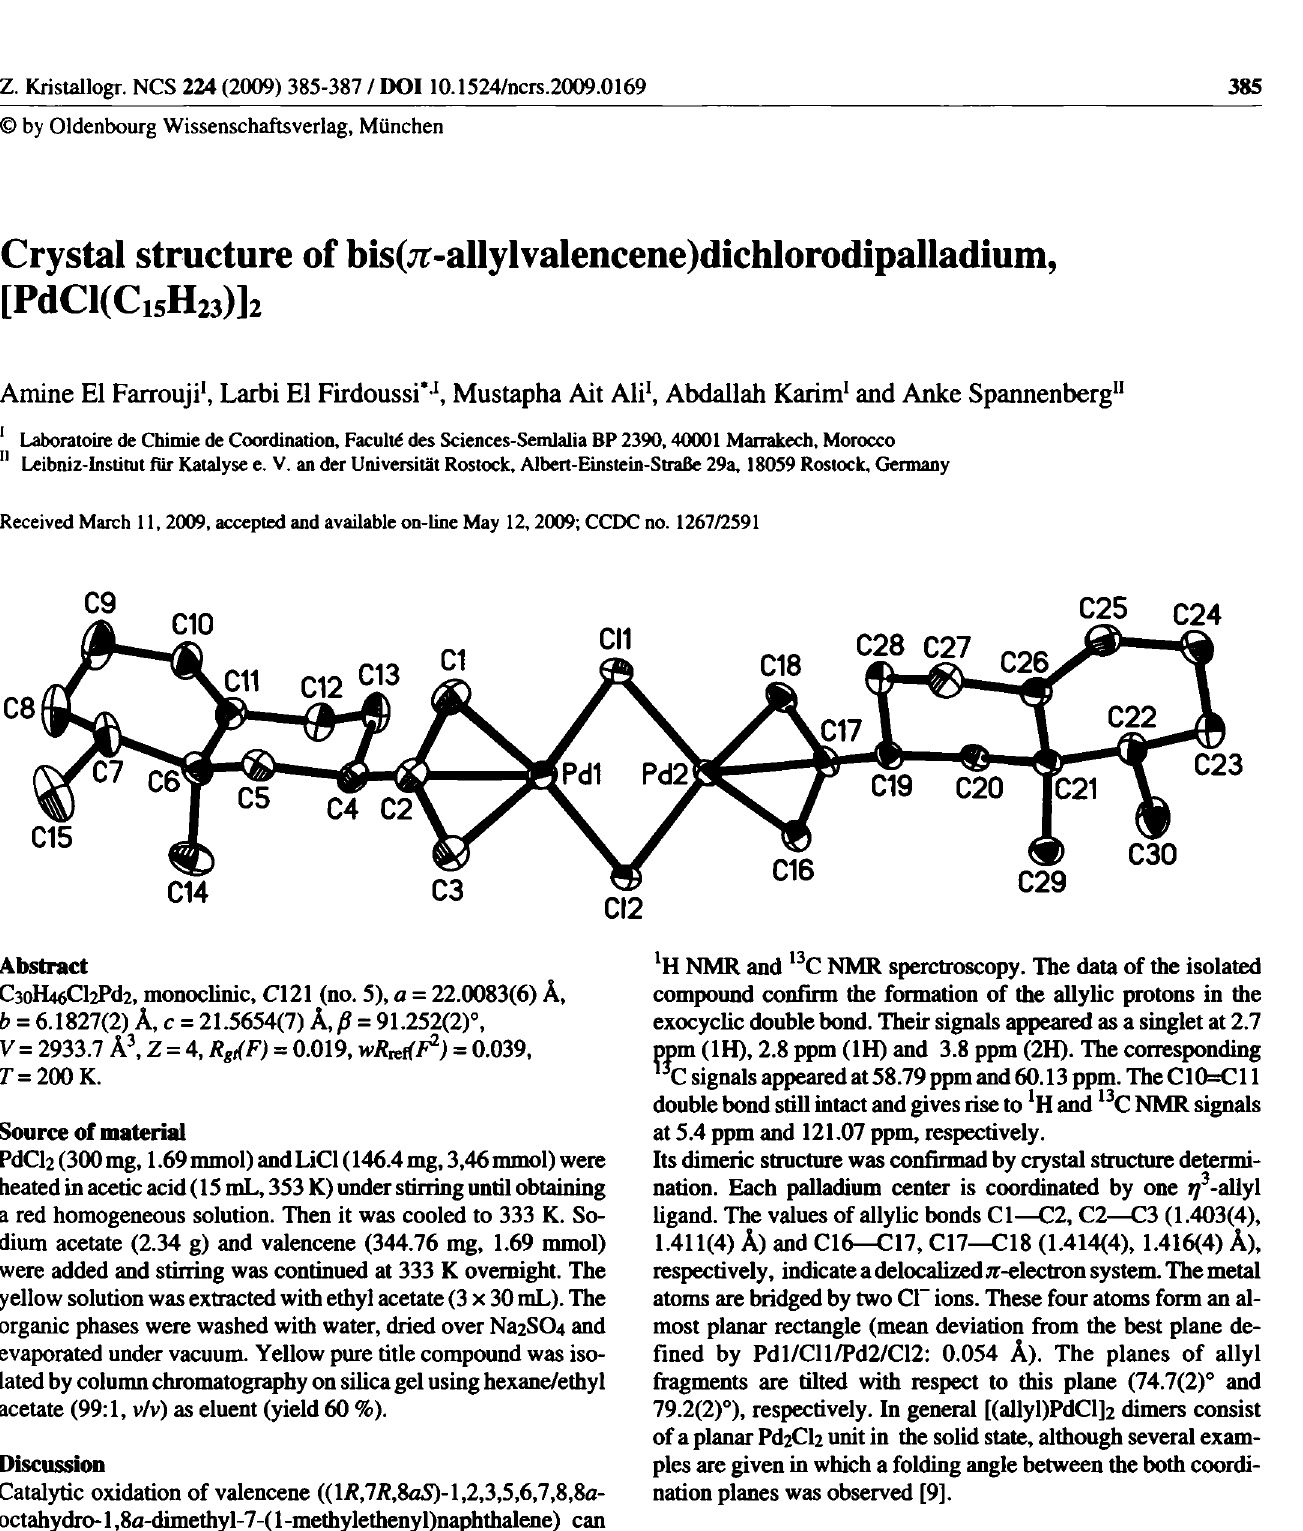
Table 1. Data collection and